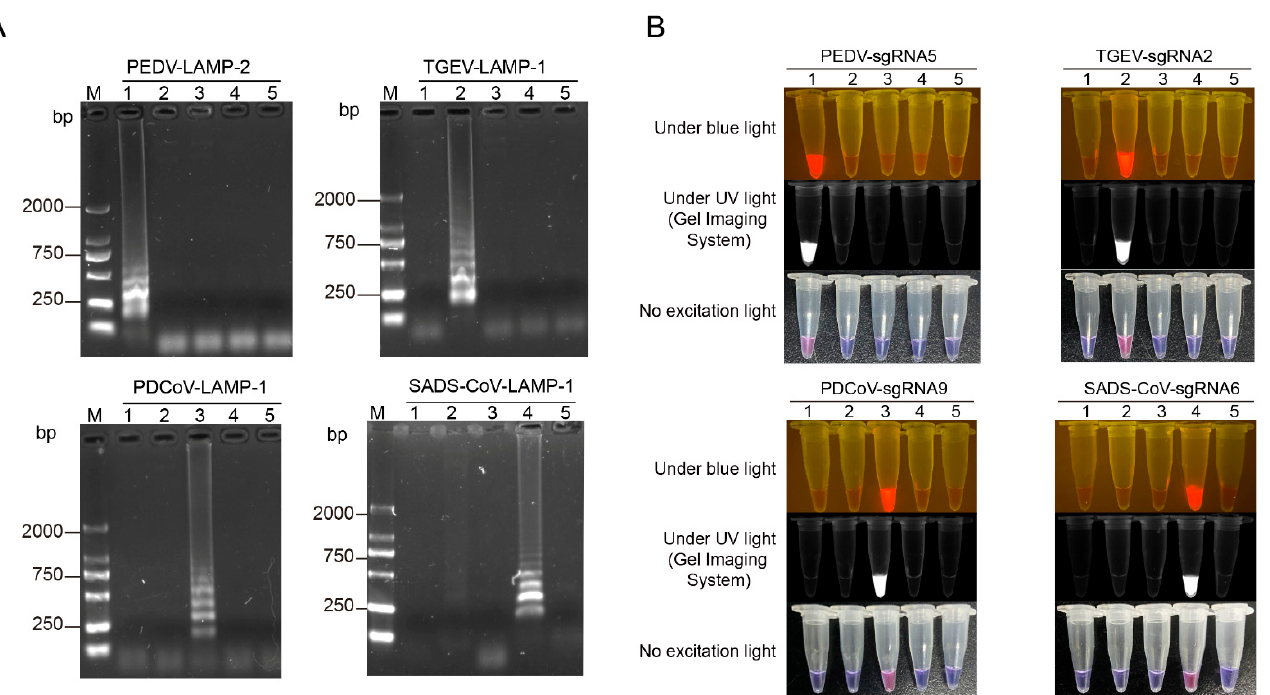
Figure 3. Specificity of LAMP-Cas12a assay for detection of four porcine coronaviruses. ( A ) The agarose gel electrophoresis for detection of specific LAMP amplicons; Lane M: 2000 DNA Ladder; bp: base pairs; Lane 1: PEDV-ORF3 plasmid as DNA template; Lane 2: TGEV-N plasmid as DNA template; Lane 3: PDCoV-N plasmid as DNA template; Lane 4: SADS-CoV-N plasmid as DNA template; Lane 5: non-template control (NTC). ( B ) The colorimetric/fluorescence signal detection under the blue (470 nM) and UV light; LAMP-amplified products of PEDV-ORF3 plasmid (1), TGEV-N plasmid (2), PDCoV-N plasmid (3), SADS-CoV-N plasmid (4), non-template control (5). No excitation light stands for white light; PEDV, porcine epidemic diarrhea virus; TGEV, transmissible gastroenteritis virus; PDCoV, porcine deltacoronavirus; SADS-CoV, swine acute diarrhea syndrome coronavirus.